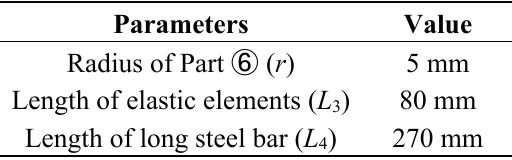
Table 1. Parameters for the force-sensing mechanism in the master device.